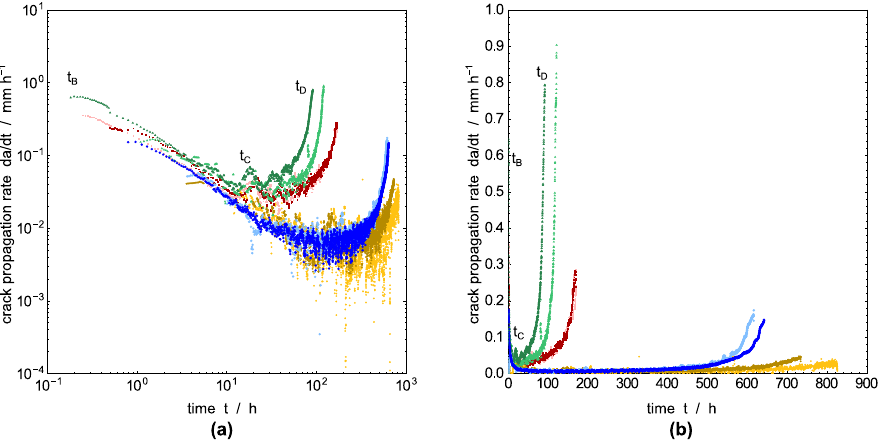
Figure 6. Derived crack propagation rate as a function of time for the different environmental media in ( a ) log–log basis and ( b ) linear scale. PFL-FR 2323 (yellow), PFL-FR 2344 (green), distilled water (blue), 2 wt% aq. Arkopal N100 (red).